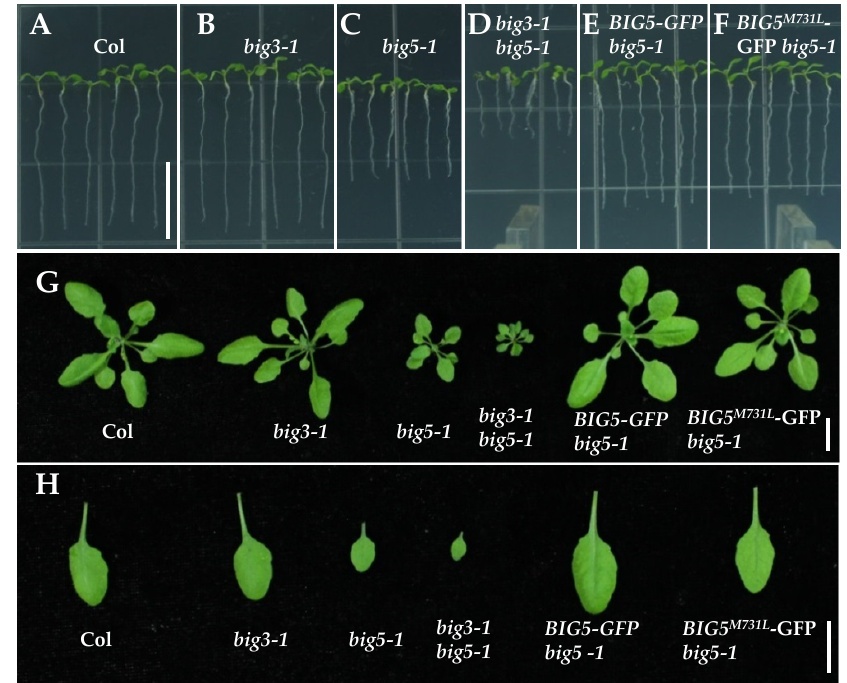
Figure 2. Both BIG5-GFP and BIG5 M731L -GFP complement big5-1 defective overall plant growth. ( A – D ) Seedlings big5-1 and big3-1 big5-1 mutants show a reduced primary root length. By contrast, Figure 2. Both BIG5 ‐ GFP and BIG5 M731L ‐ GFP complement big5 ‐ 1 defective overall plant growth. big3-1 has a normal root. ( E , F ) Both wild-type BIG5-GFP and BIG5 M731L -GFP transgenic lines could (A ‐ D) Seedlings big5 ‐ 1 and big3 ‐ 1 big5 ‐ 1 mutants show a reduced primary root length. By contrast , big3 ‐ 1 rescue big5-1 growth defects. ( G – H ) The sizes of rosette leaves of 4-week-old big5-1 and big3-1 has a normal root. (E,F) Both wild ‐ type BIG5 ‐ GFP and BIG5 M731L ‐ GFP transgenes could rescue big5 ‐ 1 growth defects. (G ‐ H) The rosettes of 4 ‐ week ‐ old big5 ‐ 1 and big3 ‐ 1 big5 ‐ 1 mutants are much smaller than Col and big3 ‐ 1 . While, BIG5 ‐ GFP and BIG5 M731L ‐ GFP fully rescued big5 ‐ 1 growth defects. Bars=1.5 cm in (A ‐ F), 1 cm in (G) and (H).